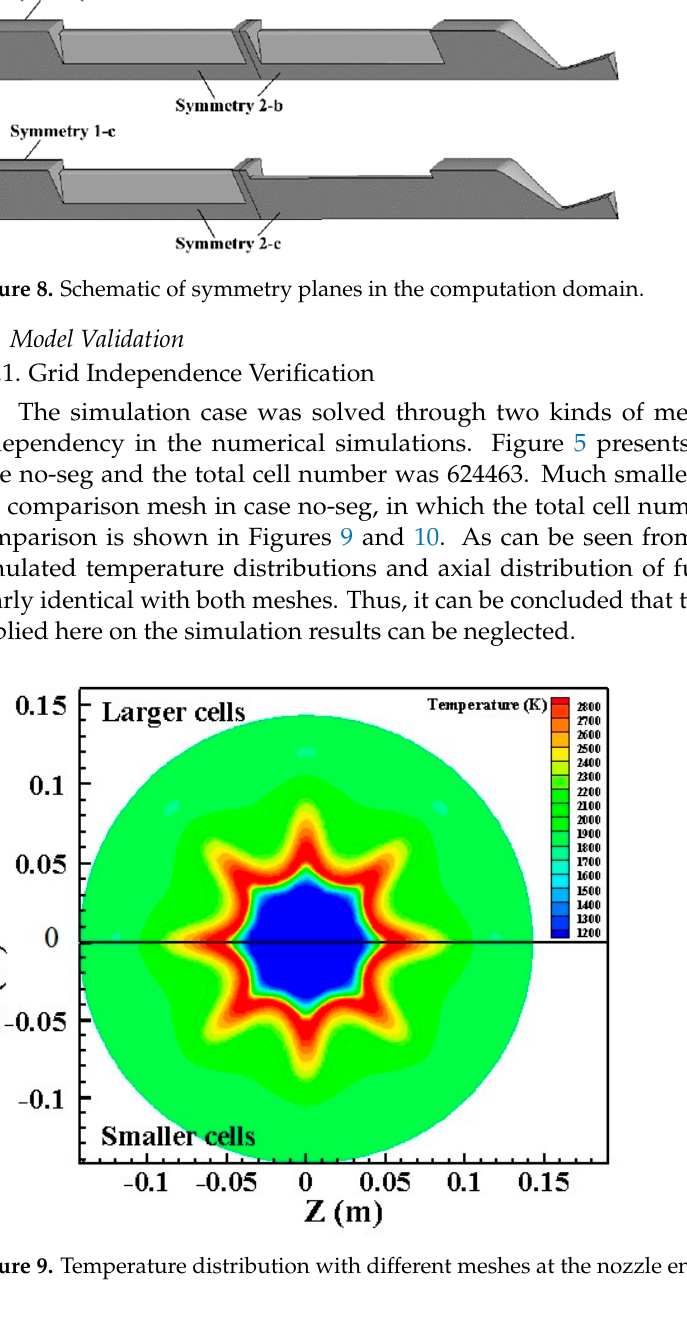
Figure 9. Temperature distribution with different meshes at the nozzle entrance.